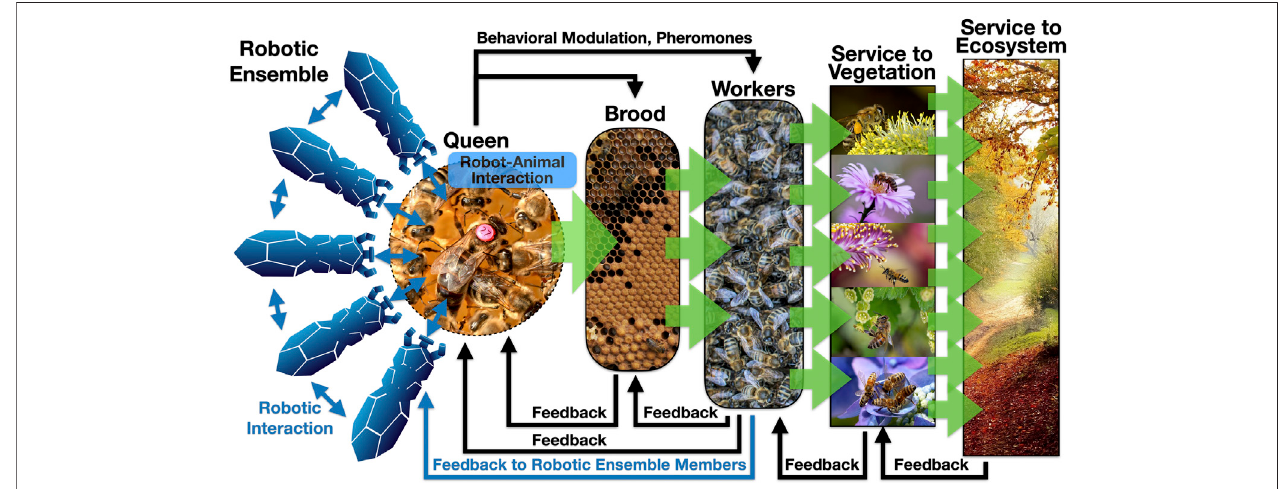
FIGURE 1 | Basic concepts of a minimum-invasive form of “ Ecosystem Hacking ” and the associated/affected feedback loops. Blue thin arrows indicate interactions in which at least one partner is a robotic agent. Black arrows indicate the naturally present interactions. Green thick arrows indicate bio-mass production or facilitation of biomass production. Roundish shapes indicate regions inside of the colony, rectangular shapes indicate regions outside of the hive. All images used here are in the public domain.